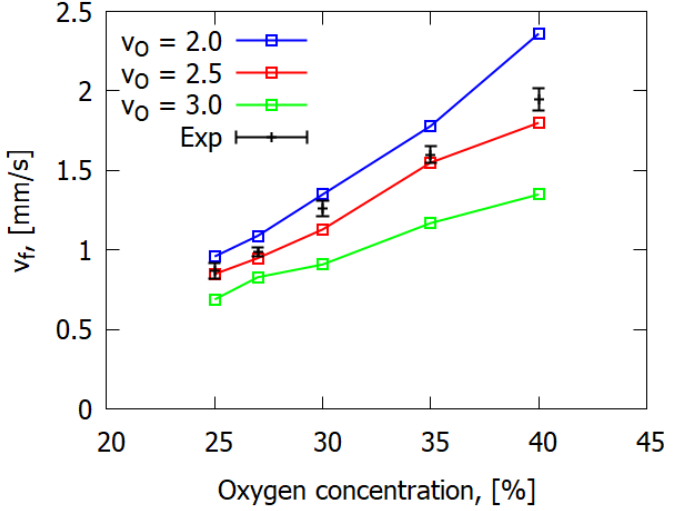
Figure 2. The effect of stoichiometric coefficient on flame spread rate; the number of the calculated curve corresponds to the value of the stoichiometric coefficient.